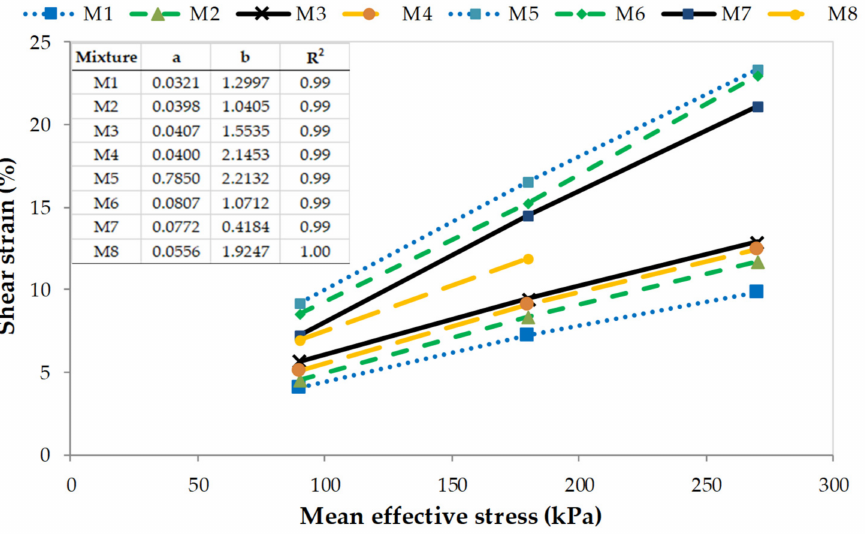
Figure 8. Variation of the shear strain corresponding to peak shear stress with change in mean effective